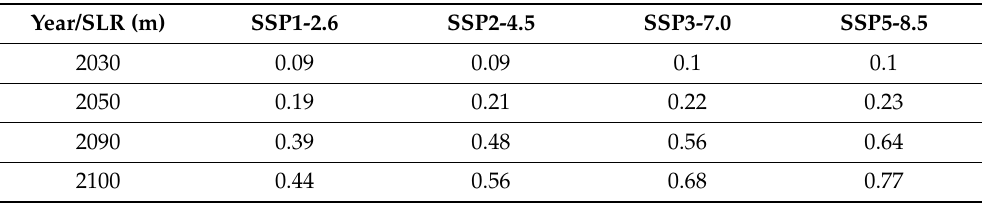
Table 3. The projected sea level rise under different shared socioeconomic pathway scenarios